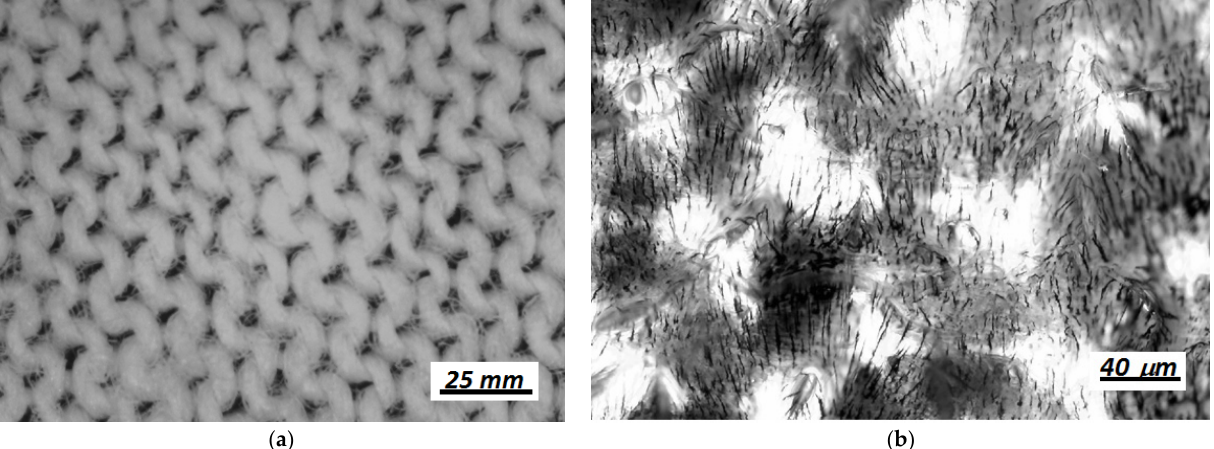
Figure 2. ( a ) GB textile image captured using a BPM-350 digital microscope for industrial inspection (Catchbest Technology Co. Ltd., Beijing, China); ( b ) image of GB doped with MRS, provided by an optical microscope (Optika, Italy), showing that Fe microparticles are oriented along radial lines when applying a static magnetic field ( B ≈ 50 mT ) .